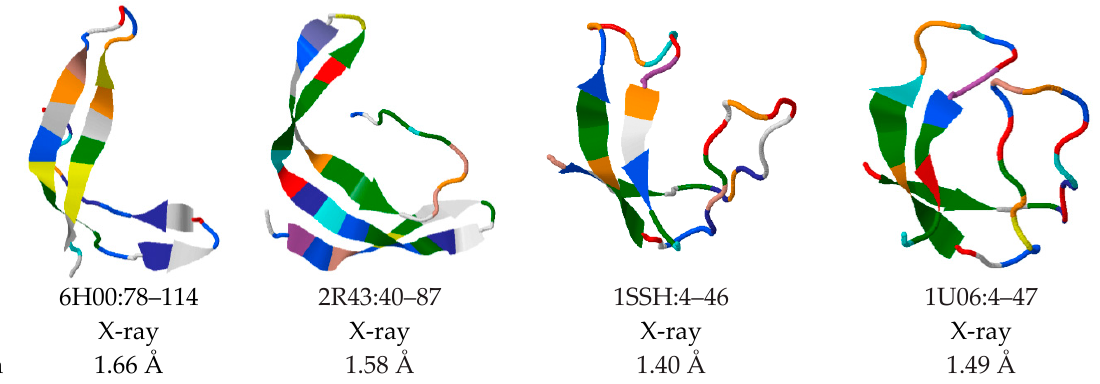
Figure 1. Ribbon diagram representations of 3 β -corners. Four examples of the tape model of the motif are presented. 3 β -corners were extracted from pyridoxine 5-phophate oxidase (6H00), HIV-1 protease (2R43), SH3 domain from a s. cerevisiae (ISSH), and chicken alpha-spectrin SH3 domain (1U06) proteins. The coordinates of the 3 β -corner in each protein (1), the experimental method for obtaining the structure (2), and the analysis resolution (less than 2Å) are indicated (3). SCOP (found at